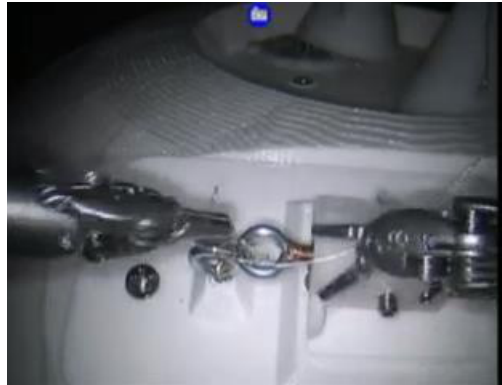
Figure 1: Proof of concept validation of the knot-tying task with a physician-controlled da Vinci surgical robot.